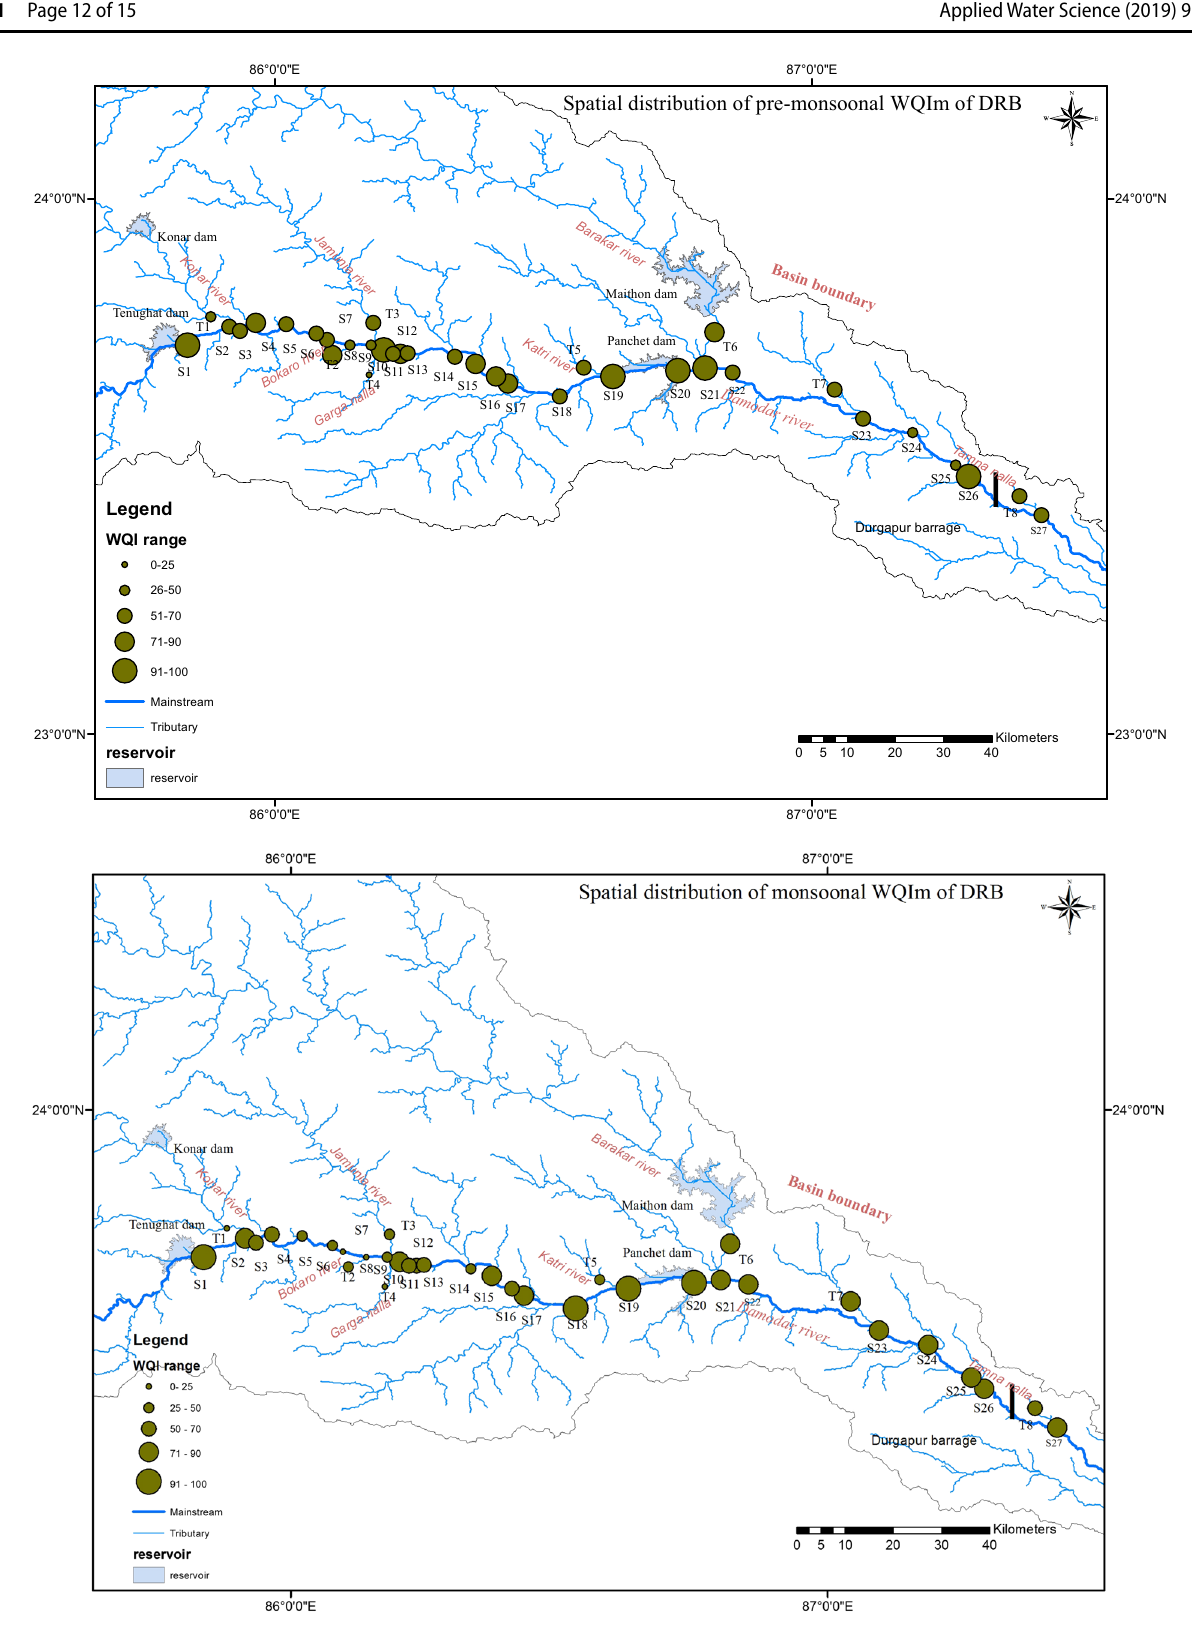
Fig. 11 Showing spatial and temporal distributions of WQI m in Damodar river and its tributaries and pollution level